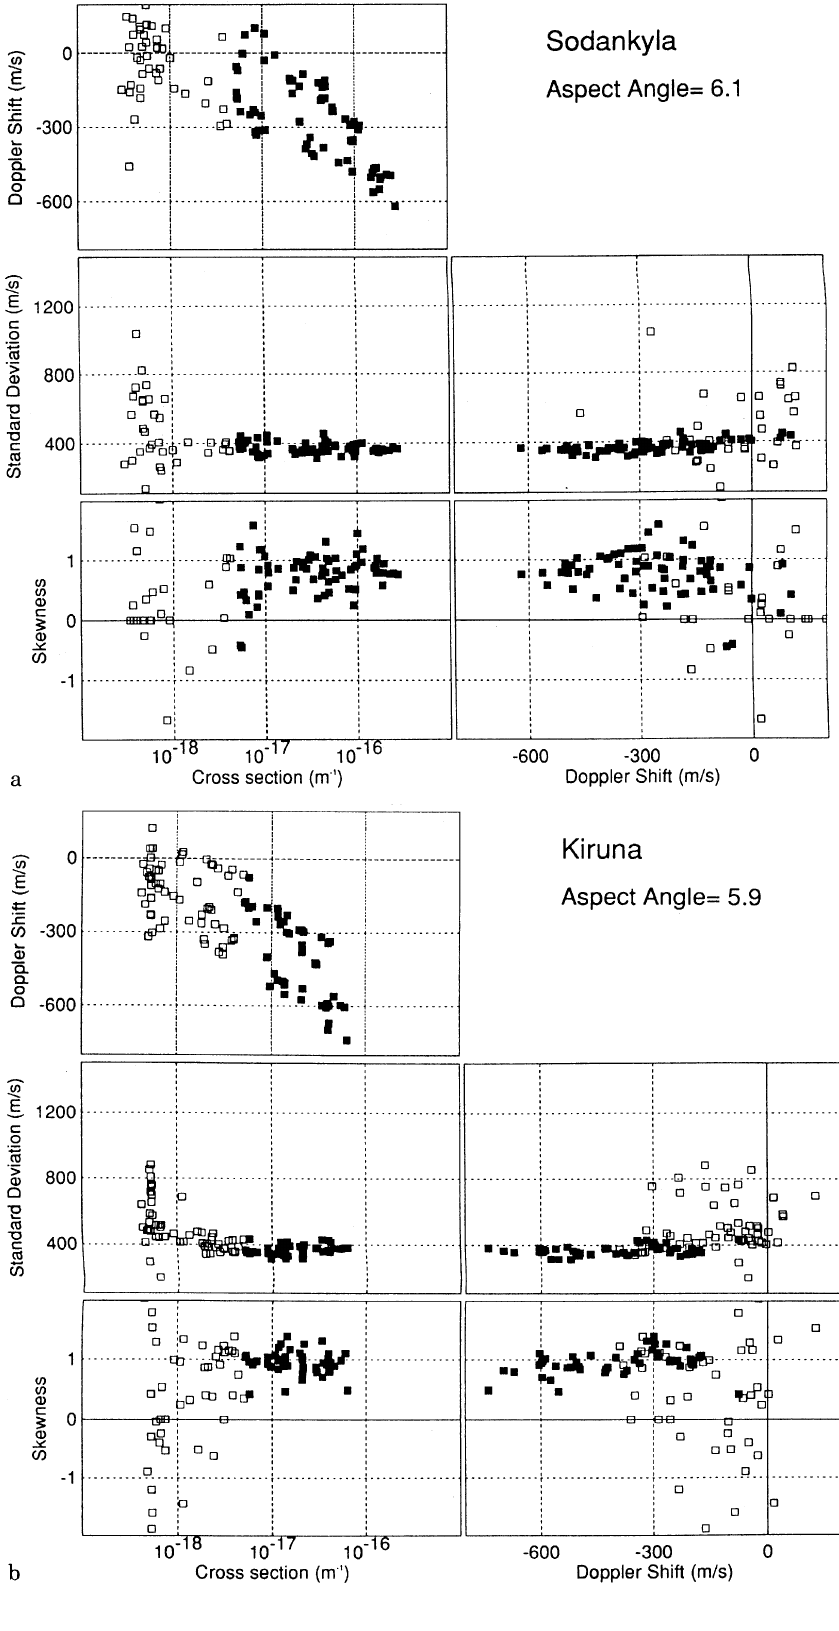
Fig. 5a, b. Comparison of the first 4 mo- ments of spectra observed on the a Troms (cid:249) -Sodankyla¨ and b Troms (cid:249) - Kiruna links, with a transmitter elevation of 14 ° . Solid symbols denote coherent scatter, while open symbols indicate inco- herent scatter